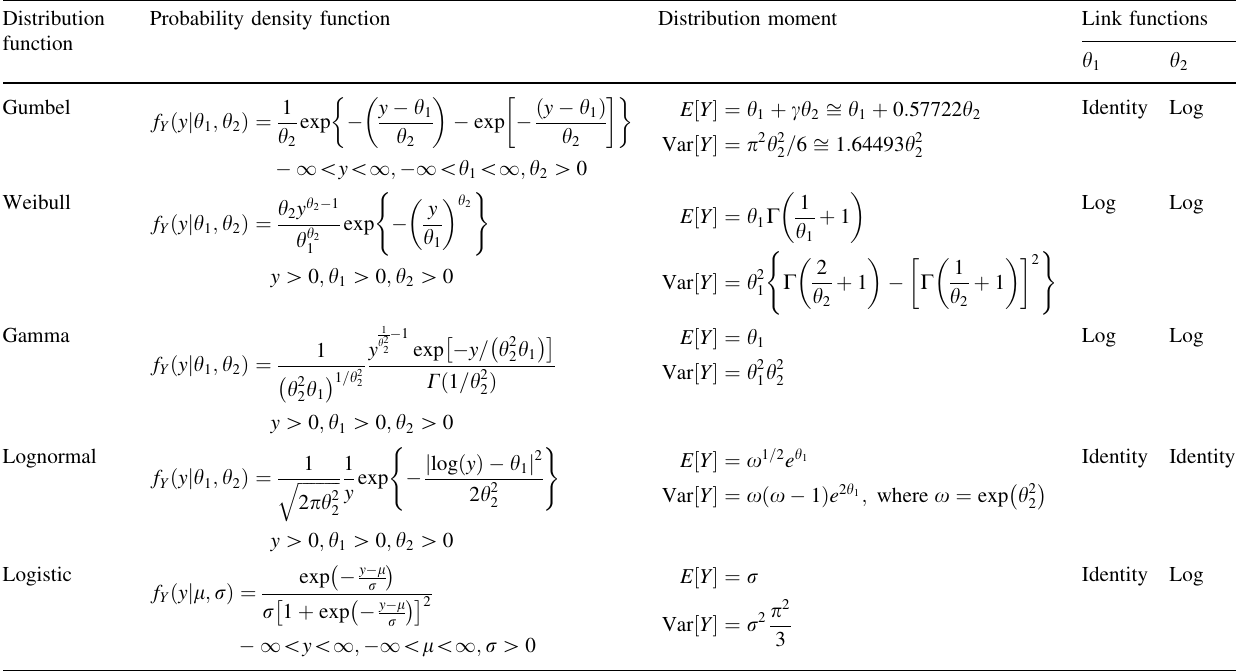
Table 1 The five distribution functions considered in this study Distribution Probability density function Distribution moment Link function